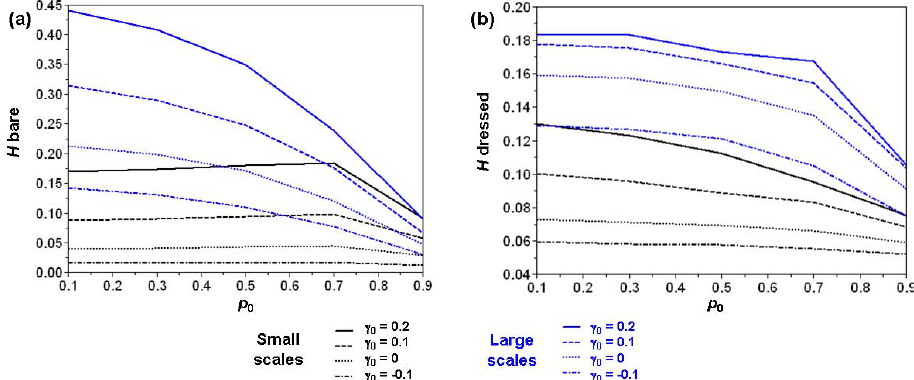
Fig. 8. Analysis of the sensitivity to γ 0 and p 0 : Bare H and Dressed H